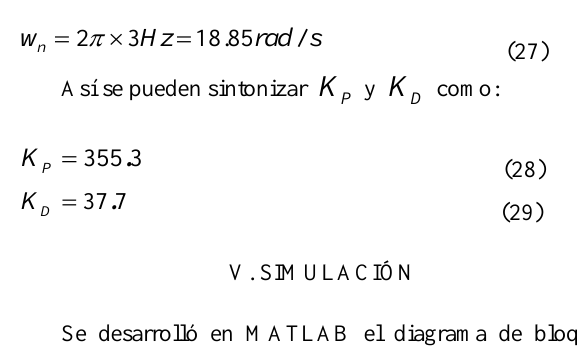
Figura 9: Respuesta del sistema contra la trayectoria deseada. Fuente: Autores, (2017).